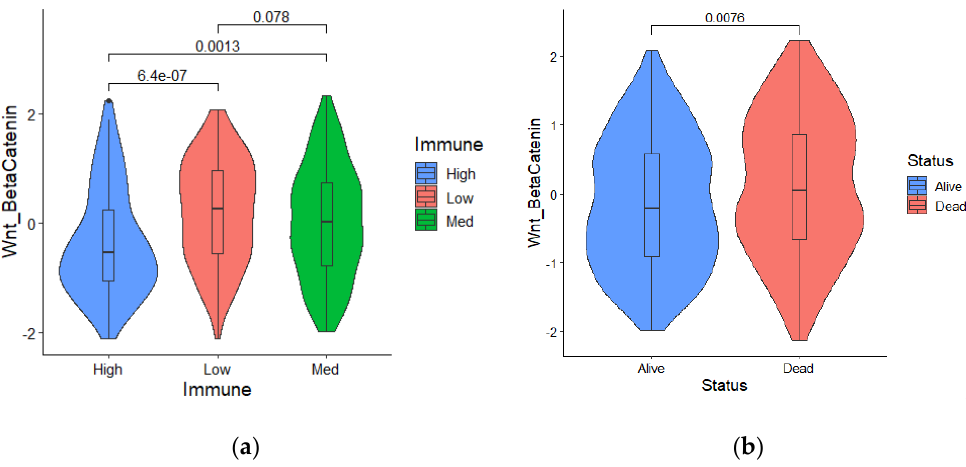
Figure 2. ( a ) Wnt/ β catenin activation was significantly elevated in patients with low immune infil- tration; ( b ) Survival status and a higher Wnt/ β activation score are significantly